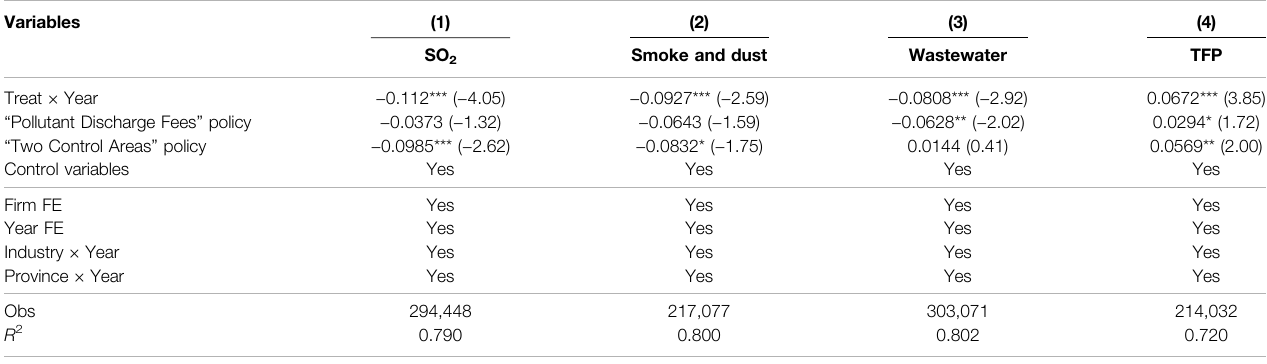
TABLE 5 | Results of excluding the impact of policies of the same